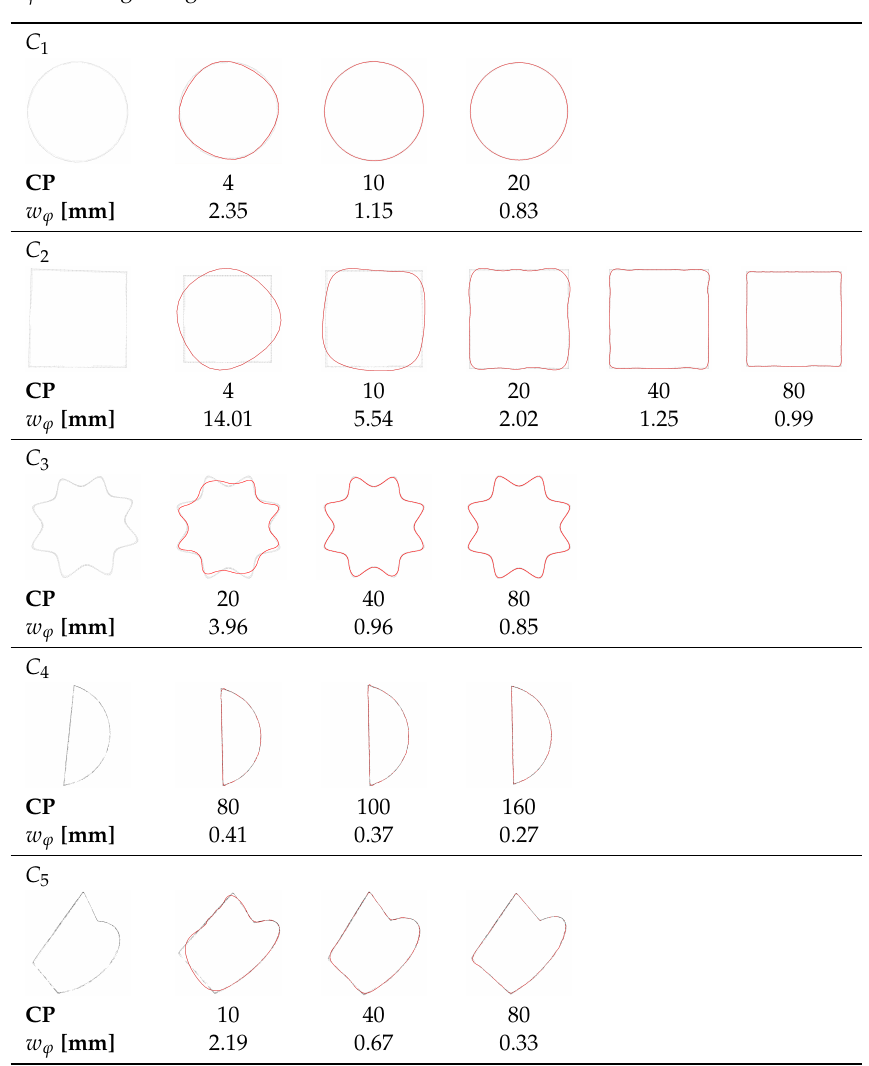
Table A3. Comparison of B-spline curve approximation of testing clouds, CP is number of control points, w ϕ is average weighted